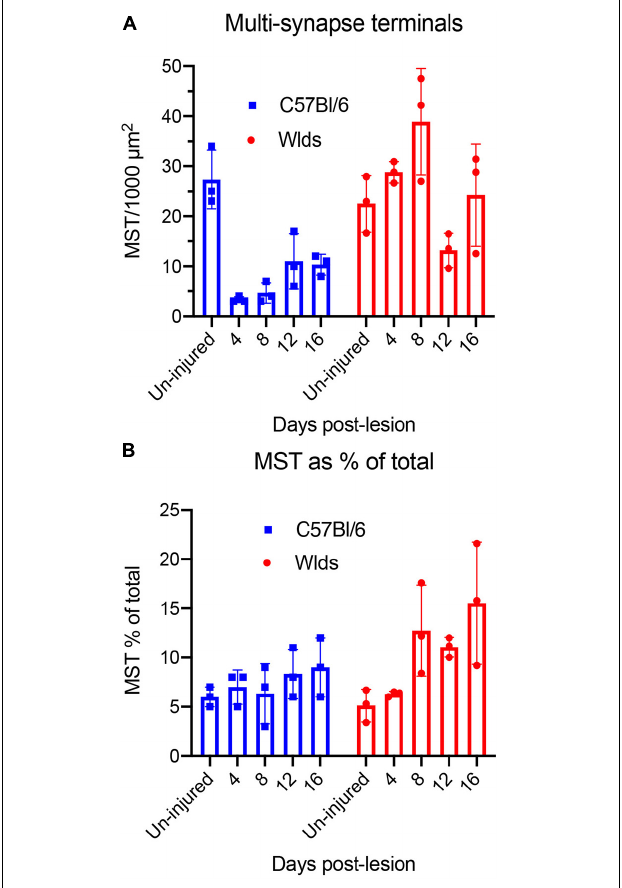
FIGURE 10 | Quantification of synapse parameters. (A) Counts of multiple synapse terminals (MSTs) contacting 2 or more PSDs per 1,000 µ m 2 of neuropil. 2-way ANOVA revealed significant differences between genotypes [ F (1,4) = 39.2, p = 0.003], and significant differences over days post-lesion [ F = 4.57, p = 0.047]. (B) Percent of presynaptic terminals that were MSTs. 2-way ANOVA revealed significant differences between genotypes [ F (1,4) = 9.57, p = 0.036], whereas differences over days post-lesion were not significant [ F = 4.27, p =